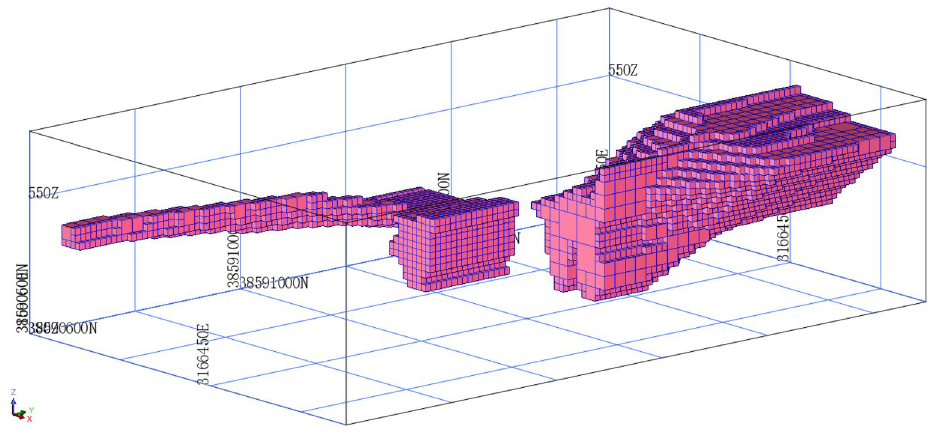
Figure 2. The block model.